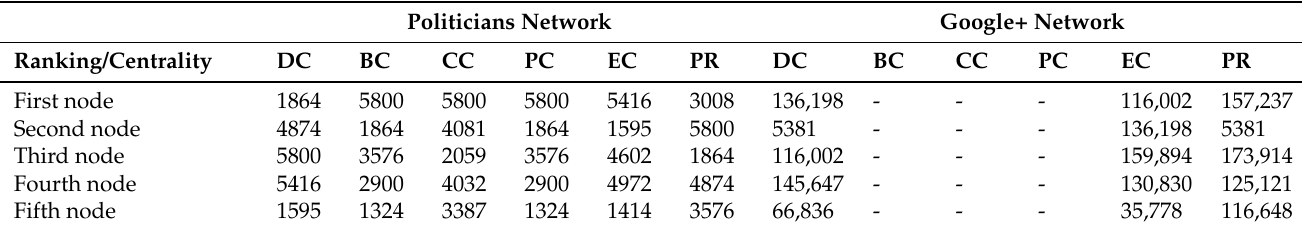
Table 4. Rank of the nodes from the Politicians and Google+ networks according to the centrality scores. Politicians Network Google+